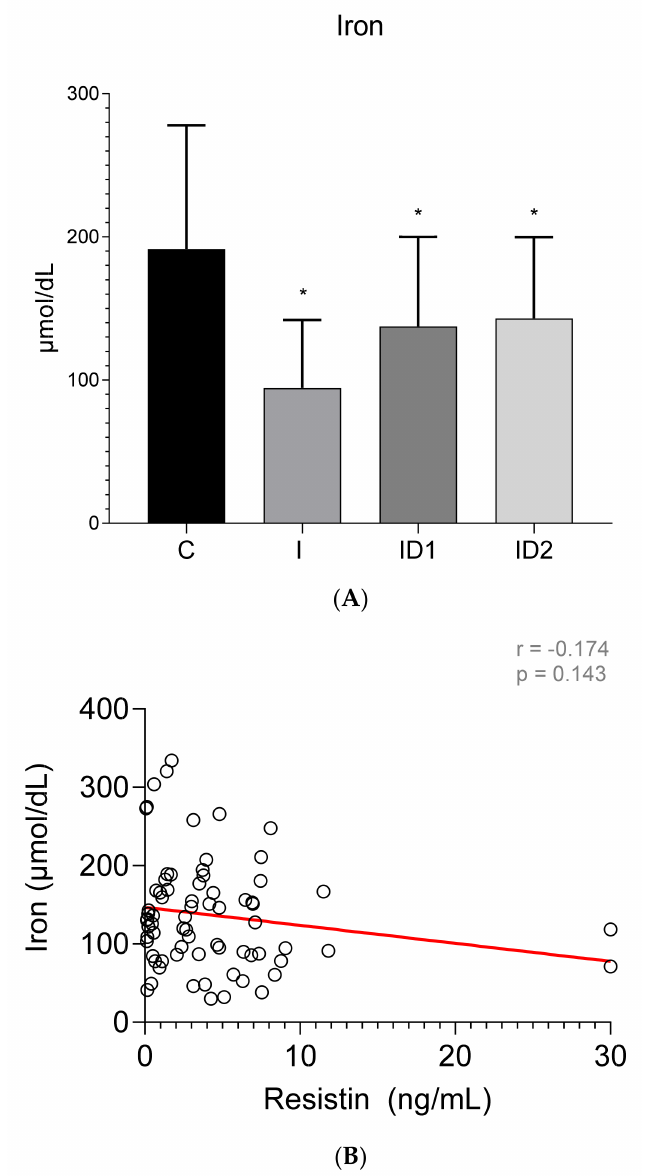
Figure 5. ( A ) Plasma iron concentration ( µ mol/dL) in the different groups. Control group (C) n = 14, inflammatory group (I) n = 21, mild insulin dysregulation group (ID1) n = 18, severe insulin dysregulation group (ID2) n = 19. Bars represent mean + SD. Asterisks indicate significant differences with the control group (* p < 0.05). ( B ) Correlation between plasma iron concentration ( µ mol/dL) and plasma resistin concentration (ng/mL) in 72 horses. The linear regression line is draw red solid (n = 72, r = 0.174, p =